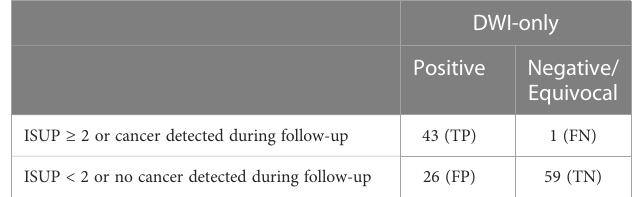
TABLE 4 2x2 contingency table for detecting clinically signi fi cant prostate cancer for the retrospective